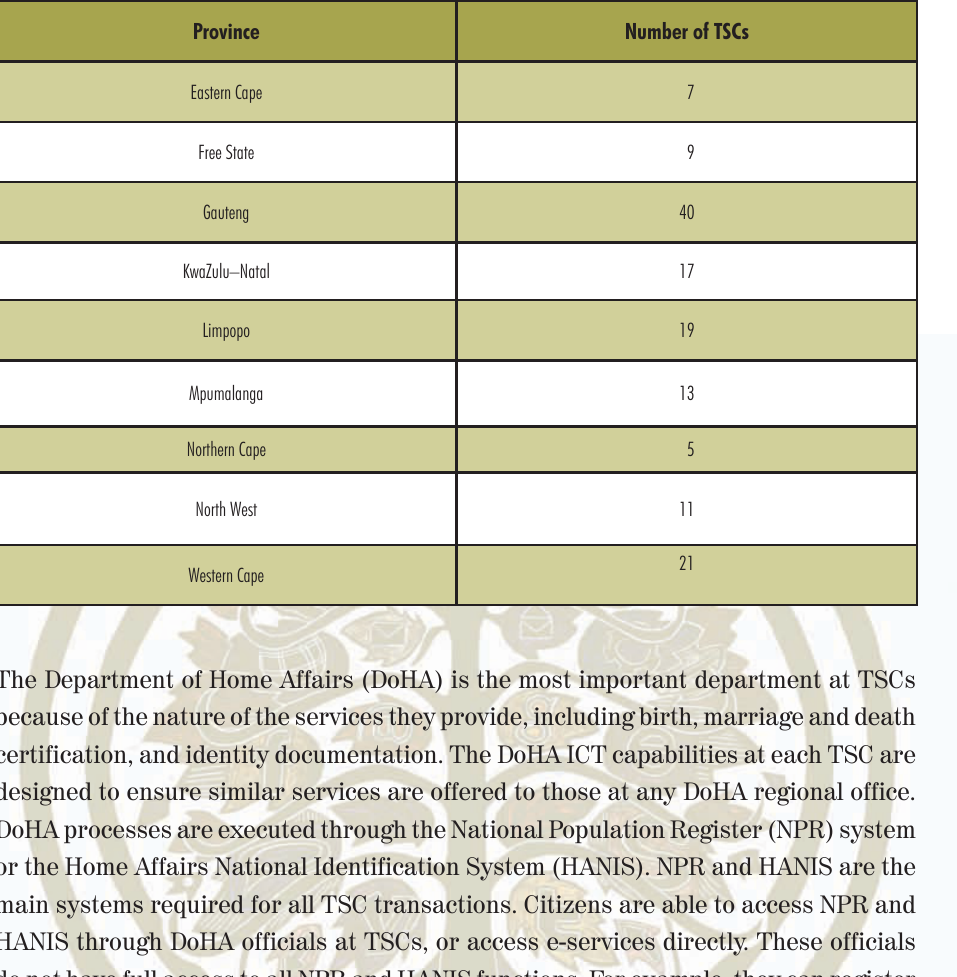
THUSONG SERVICE CENTRES